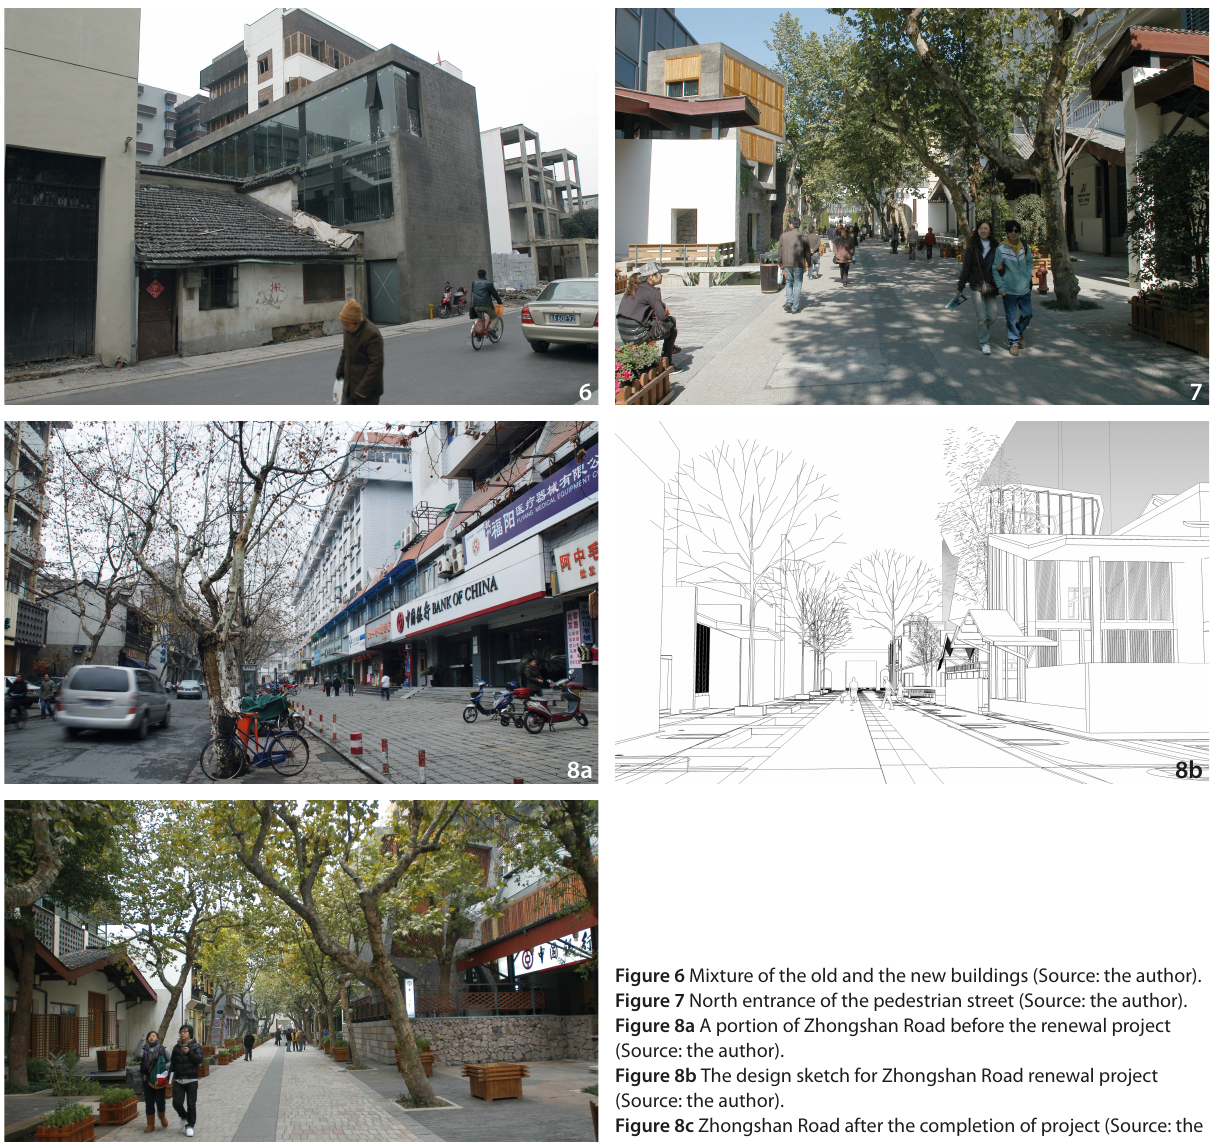
Figure 6 Mixture of the old and the new buildings (Source: the author). Figure 7 North entrance of the pedestrian street (Source: the author). Figure 8a A portion of Zhongshan Road before the renewal project (Source: the author). Figure 8b The design sketch for Zhongshan Road renewal project (Source: the author). Figure 8c Zhongshan Road after the completion of project (Source: the author). 8c